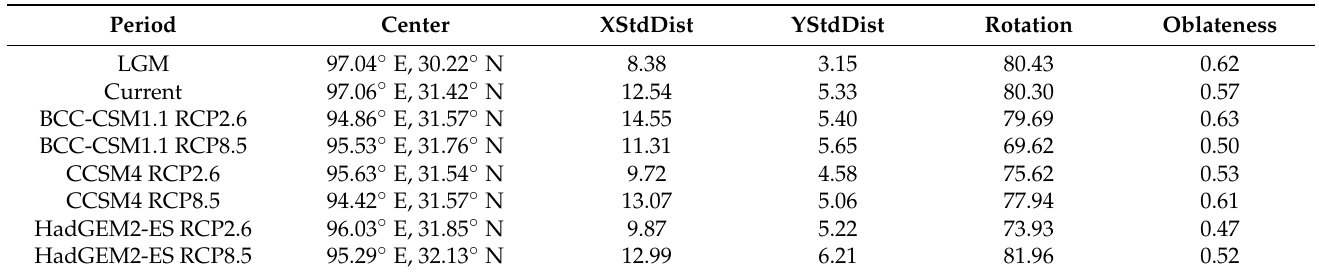
Table 6. The parameters of the standard deviation ellipse (SDE) of the suitable habitat of J. tibetica in different periods.